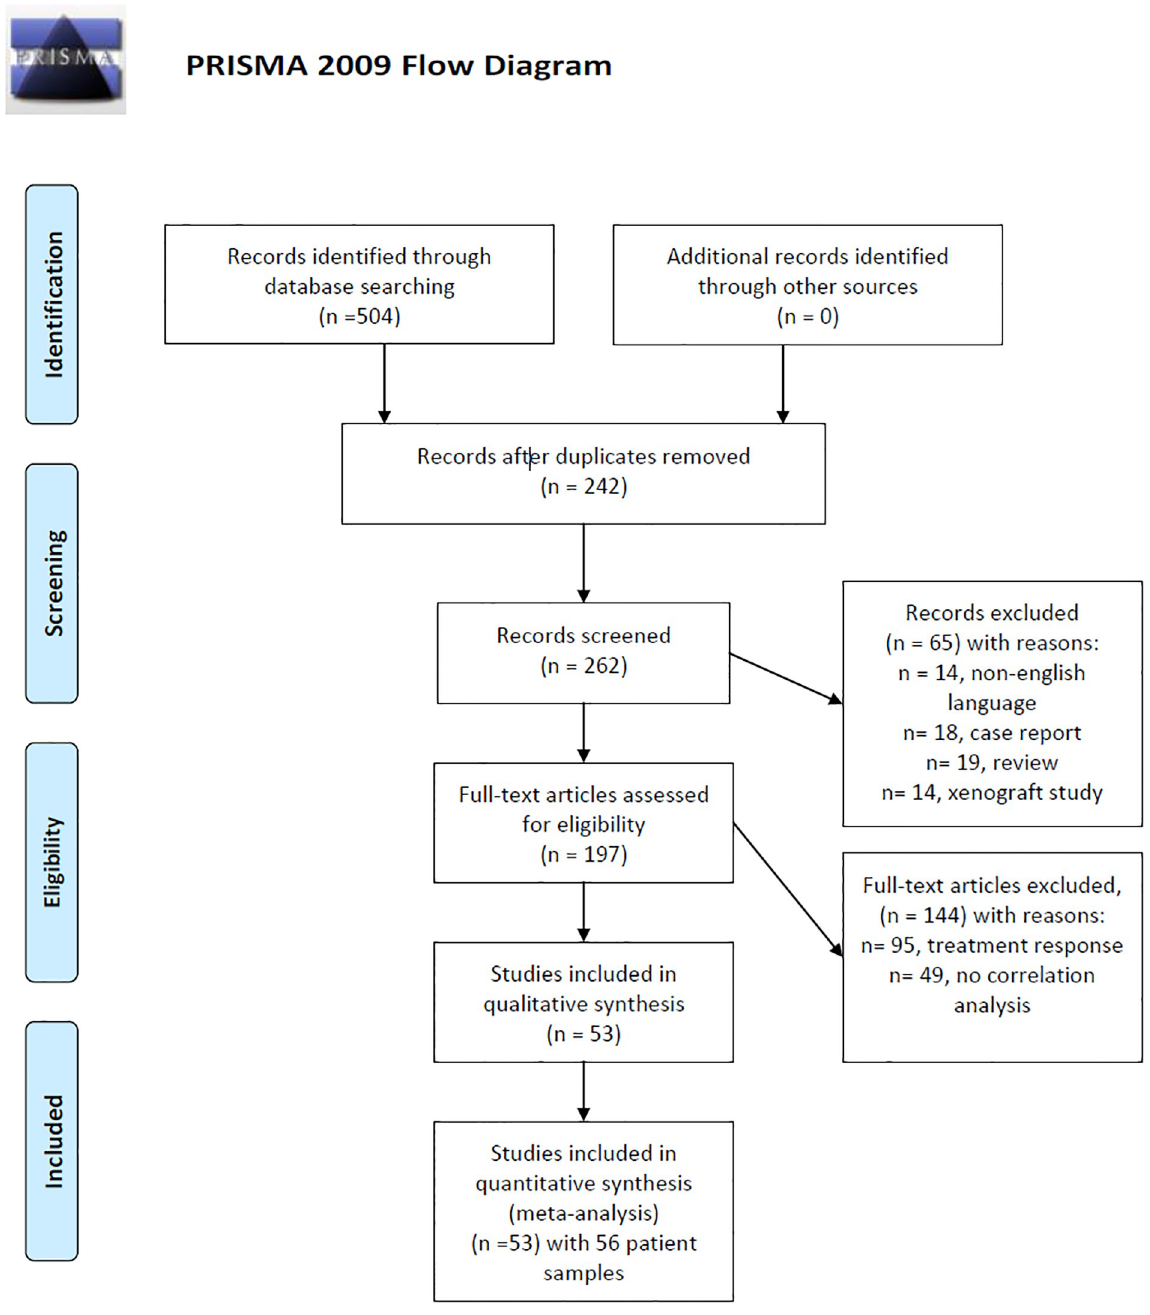
Fig 1. PRISMA flow chart. An overview of the paper acquisition. Finally, 53 articles were suitable for the analysis. From : Moher D, Liberati A, Tetzlaff J, Altman DG, The PRISMA Group (2009). P referred R eporting I tems for S ystematic R eviews and M eta- A nalyses: The